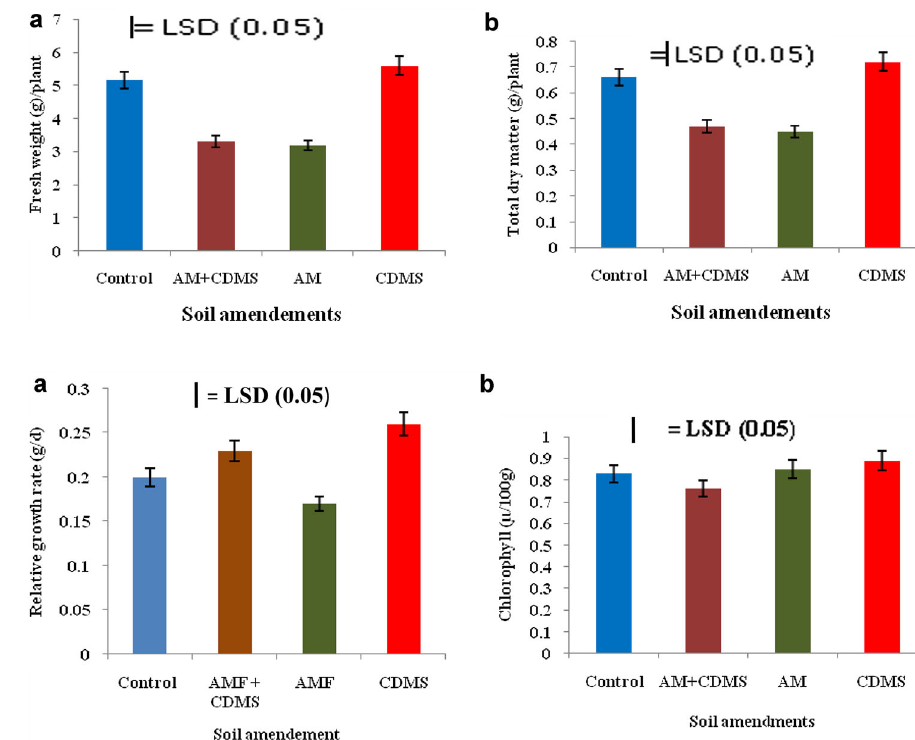
Fig. 2 a Influence of various soil amendements on weight of fresh shoot (g) of Amaranthus cruentus. b Influence of various soil amendements on biomass yield (g) of A. cruentus